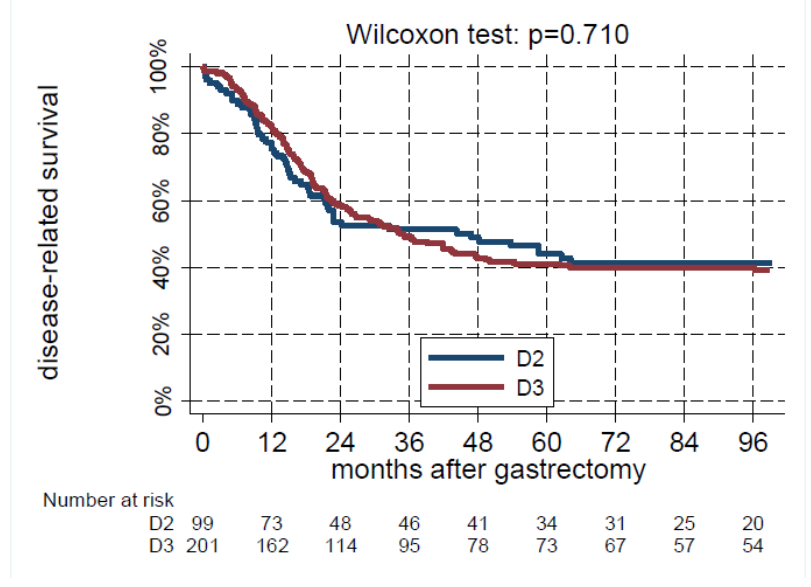
Figure 1. Disease-related survival as a function of the extension of lymphadenectomy, estimated using the Kaplan-Meier method.